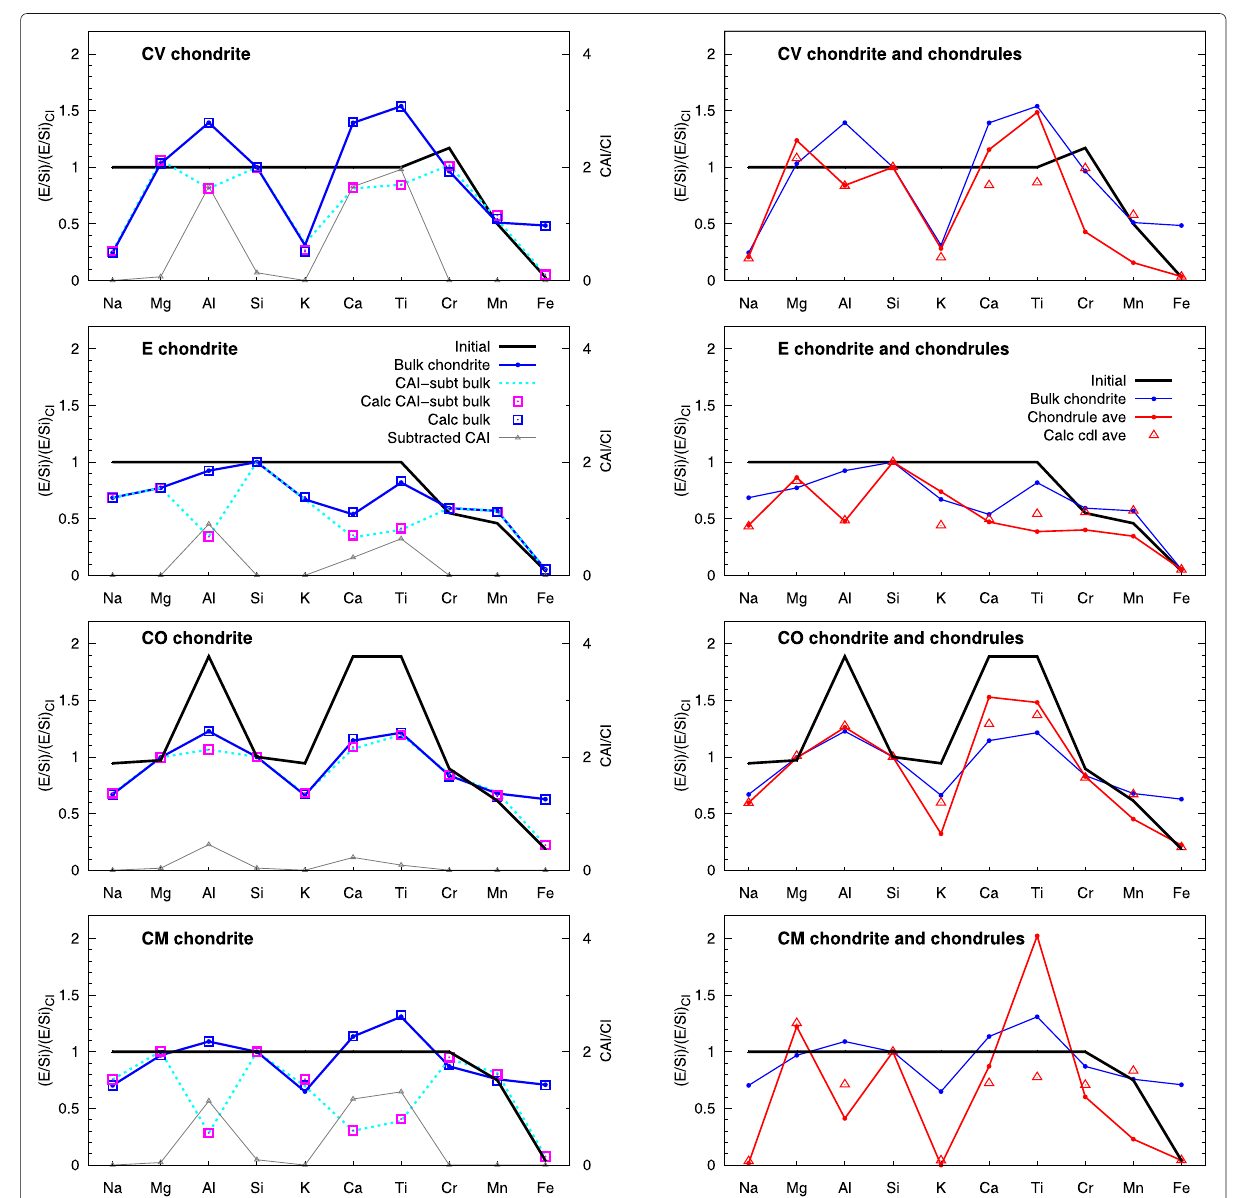
Fig.2 Results of numerical fittings for CV, E, CO and CM chondrites, as compared to the composition of real chondrites. CAI-subt bulk: ‘CAI-subtracted bulk composition’ of a specified chondrite type (see text). Calc CAI-subt bulk: calculated CAI-subtracted bulk composition of a specified chondrite type. Subtracted CAI: mol% of CAI-forming elements in the bulk chondrite, normalized to its CI abundance (refer to CAI/CI on the right hand scale). The initial composition used for CO chondrite is ‘CAI-loaded CI silicate composition’ described in text. See the caption of Fig. 1 for other